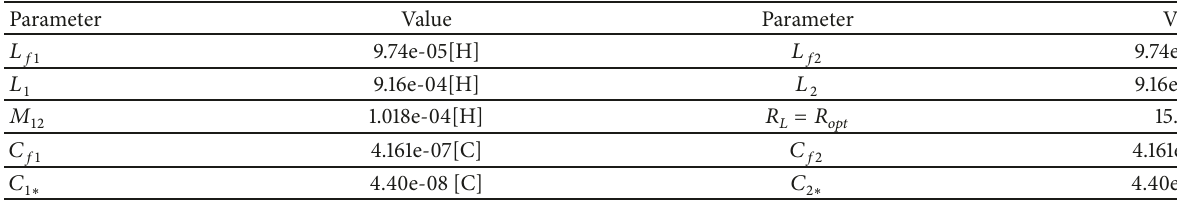
Table 5: Parameters of the simulated circuit with LCC compensation.